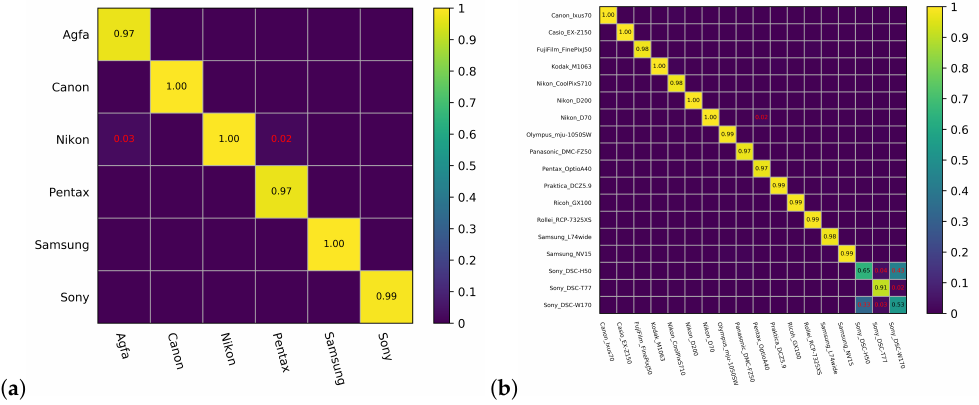
Figure 8. Confusion matrix of ( a ) brand level and ( b ) model level identification.